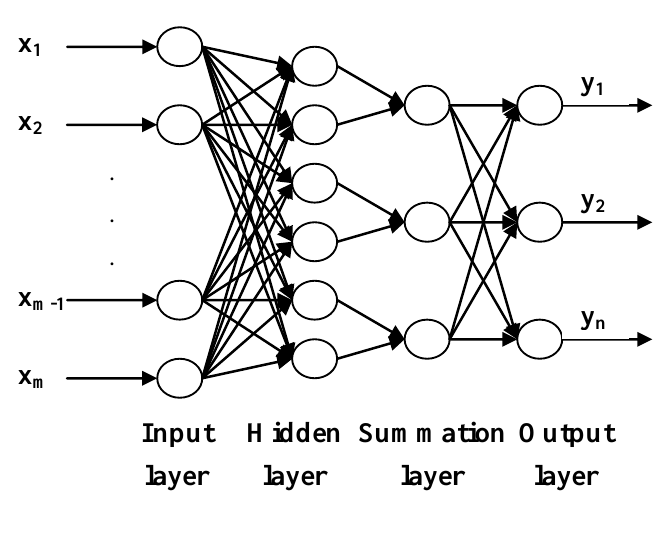
Figure 6. The diagram of the